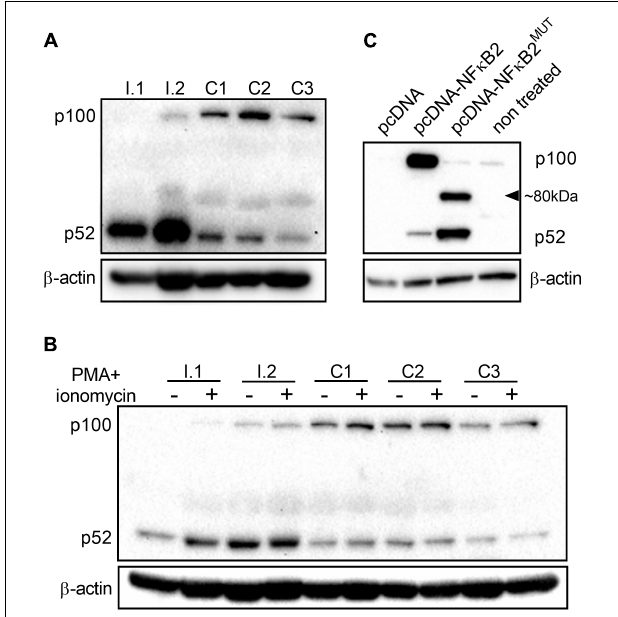
FIGURE 4 | Expression of p100/p52 protein. (A) Immunoblot of whole-cell lysates from PBMC isolated from individuals with c.1831C > T mutation (I.1, I.2) and wild-type controls (C1, C2, C3). (B) Immunoblot of whole-cell lysates from freshly isolated PBMC and cells stimulated for 3 h with phorbol 12-myristate 13-acetate (PMA, 50 ng/mL) and ionomycin (1 µ g/mL). Cells were isolated from family members (I.1, I.2) and wild-type controls (C1, C2, C3). (C) Before immunoblot analysis, HepG2 cells were transfected with expression vectors encoding coding sequence of wild-type NFKB2 gene (pcDNA-NFKB2), or c.1831C > T mutated variant (pcDNA-NFKB2 MUT